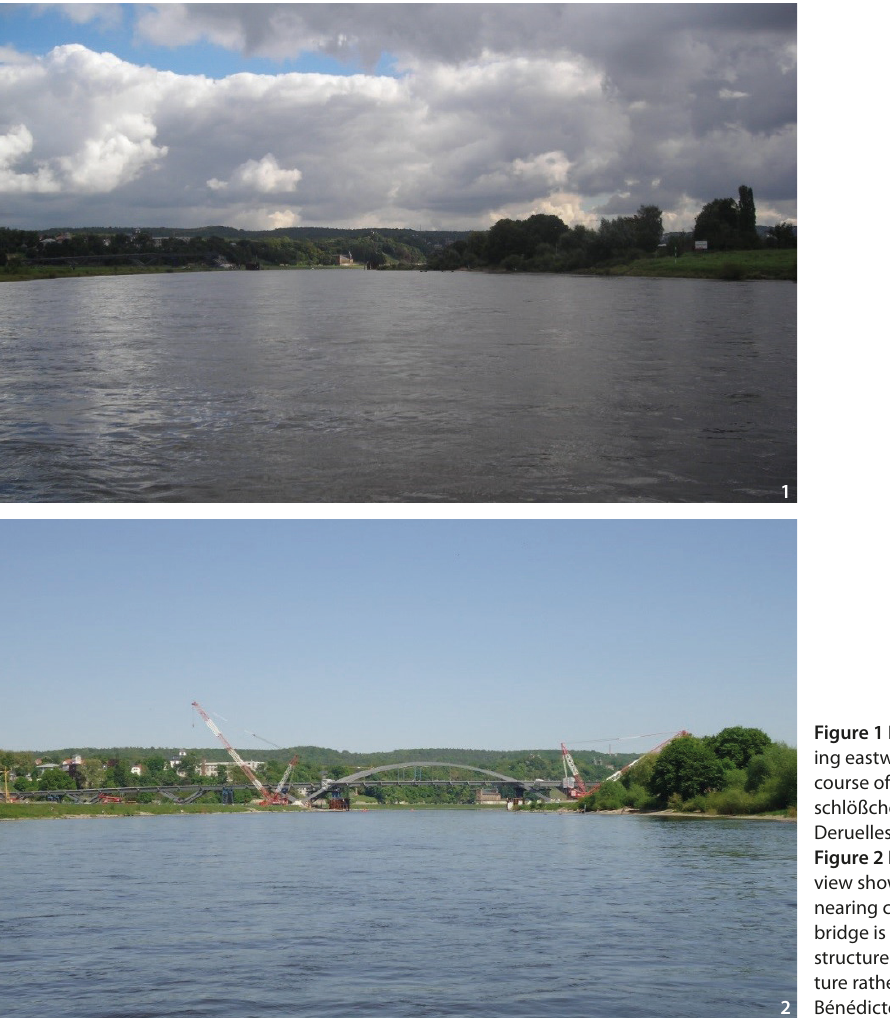
Figure 1 Dresden Elbe Valley, 2008: View look- ing eastwards from the city centre along the course of the Elbe to the site of the Wald- schlößchen Bridge crossing. (Source: Perrine Deruelles). Figure 2 Dresden Elbe Valley, 2011: The same view showing the Waldschlößchen Bridge nearing completion. From this viewpoint the bridge is clearly visible, notably the super- structure above the carriageway; a design fea- ture rather than a structural necessity. (Source: Bénédicte